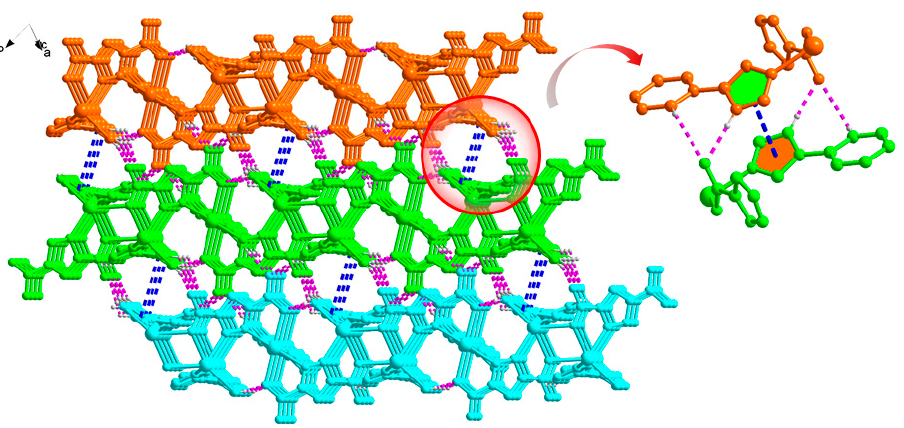
Figure 4. 3D supramolecular network structure of 1 linked by hydrogen bonding (pink dotted line)